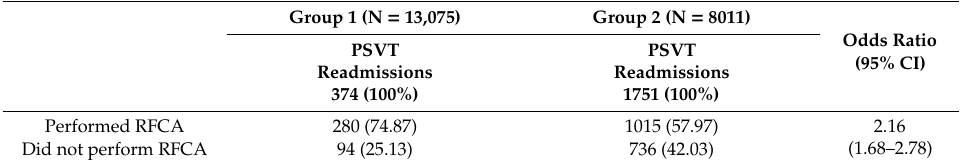
Table 5. Odds ratio for RFCA in readmitted PSVT patients who did or did not undergo RFCA